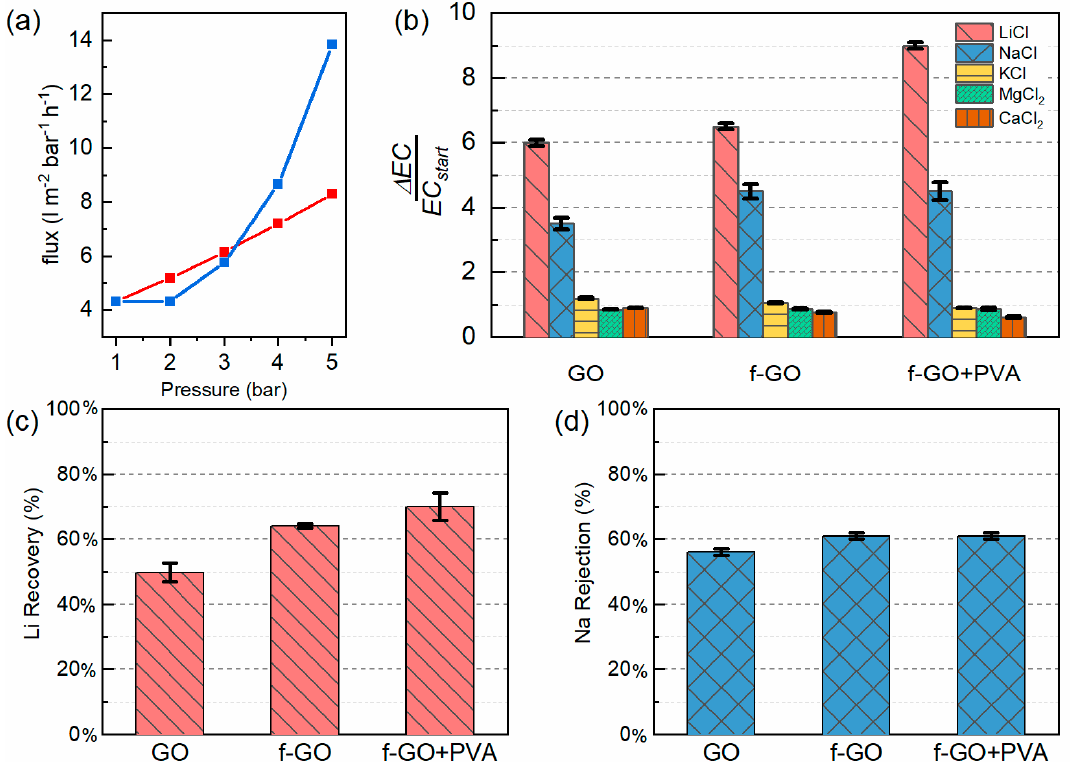
Figure 4. ( a ) Permeability curve of the GO (in red) and f-GO+PVA (in blue) membrane, ( b ) conductivity measurements, ( c ) lithium recovery rate, and ( d ) sodium rejection rate from ICP mass analyses of the three membranes. The conductivity measurements were performed in the salt solutions whereas the ICP mass measurements were carried out on the stripping solutions.